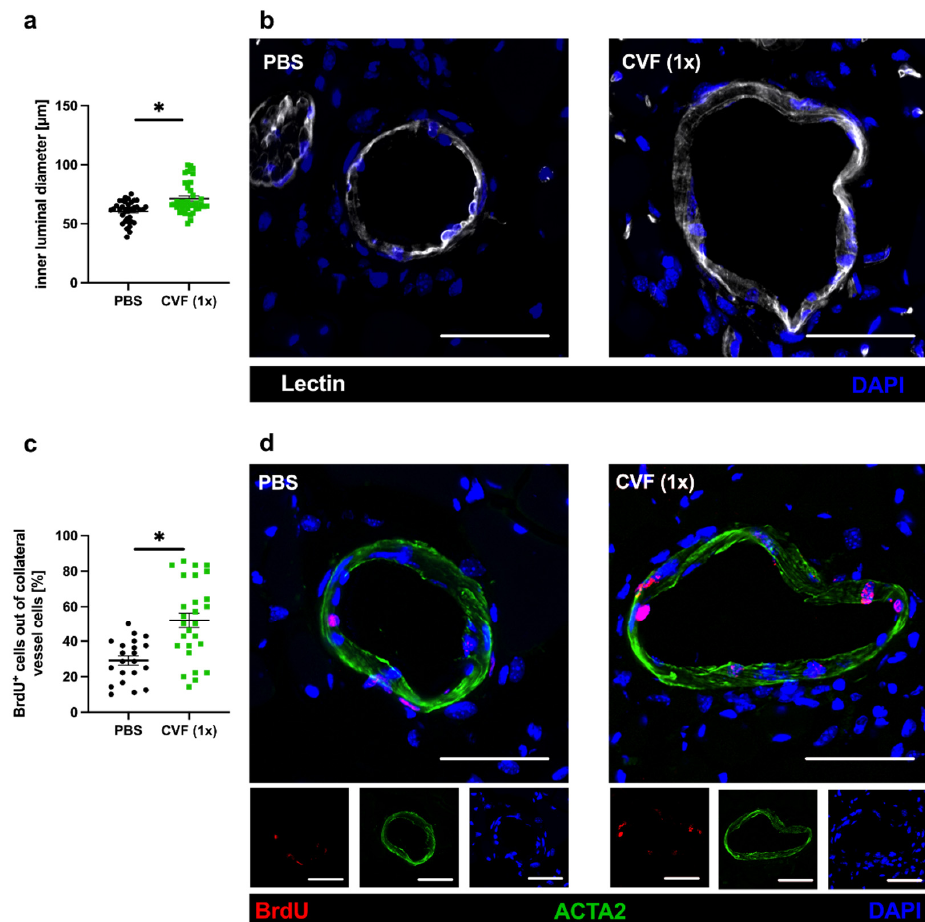
Figure 3. Single-dose application of the cobra venom factor (CVF (1x)) 24 h prior to femoral artery ligation (FAL) enhances collateral growth. The scatter plots describe ( a ) the inner luminal diameter of proliferating collaterals and ( c ) the number of proliferating vascular cells (BrdU+, bromodeoxyuridine+ cells) per growing collateral in percent of phosphate-buffered saline (PBS)- and CVF-treated mice 7 days after FAL. Data are the means ± S.E.M., n = 5 mice per group, n > 10 values per group, * p < 0.05 (PBS vs. CVF (1x)) by the unpaired Student’s t -test. ( b , d ) Representative immunofluorescence pictures of growing collaterals collected from PBS-treated (left panels) and CVF (1x)-treated (right panels) mice 7 days after ligation stained with lectin (white), indicating the luminal vessel boundary ( b , upper images), as well as antibodies against BrdU (red), marking proliferating cells and ACTA2 (green) staining smooth muscle cells ( d , lower images). DAPI (blue) was used to label the nuclei; scale bar: 50 µ